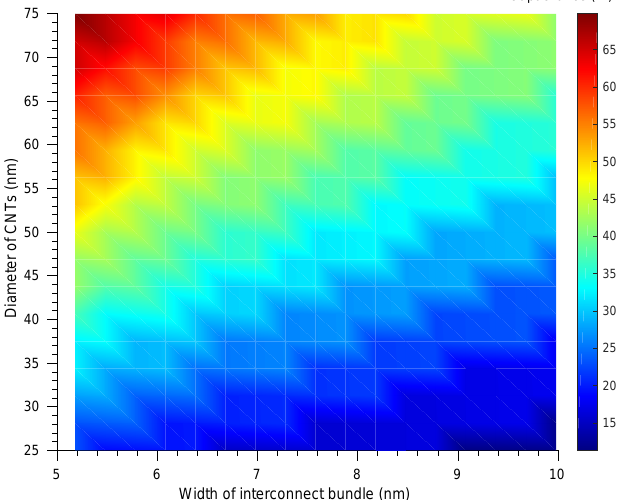
Figure 4. Contemporaneous denouement of capacitance of the squarely packed bundle of mixed CNTs by varying the width of the bundle and the diameter of